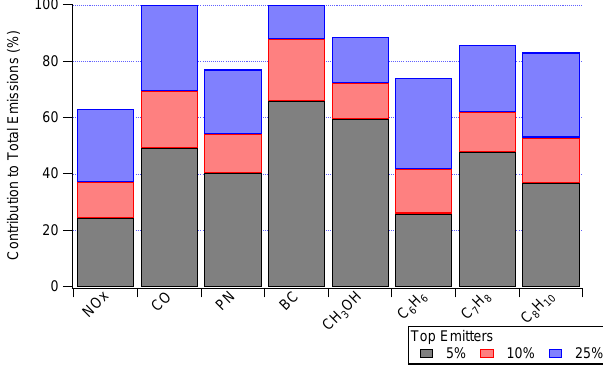
Figure 6. Stacked bar plot showing the contribution of the top 5, 10, and 25% heaviest emitters to the total emissions captured through the plume